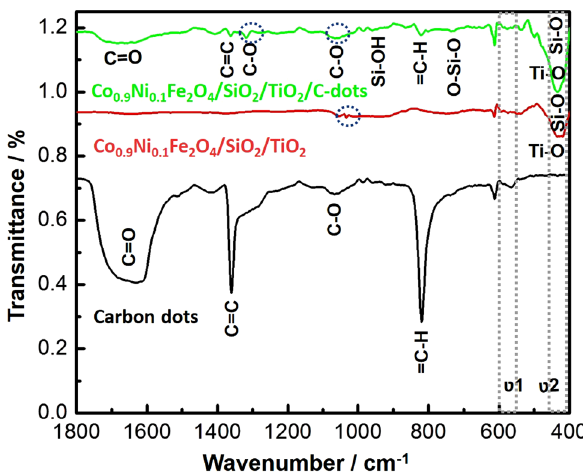
Figure 7. FTIR analysis of the Co x Ni 1−x Fe 2 O 4 ; x = 0.9/SiO 2 /TiO 2 /C-dots nanocomposite, bare C-dots and Co